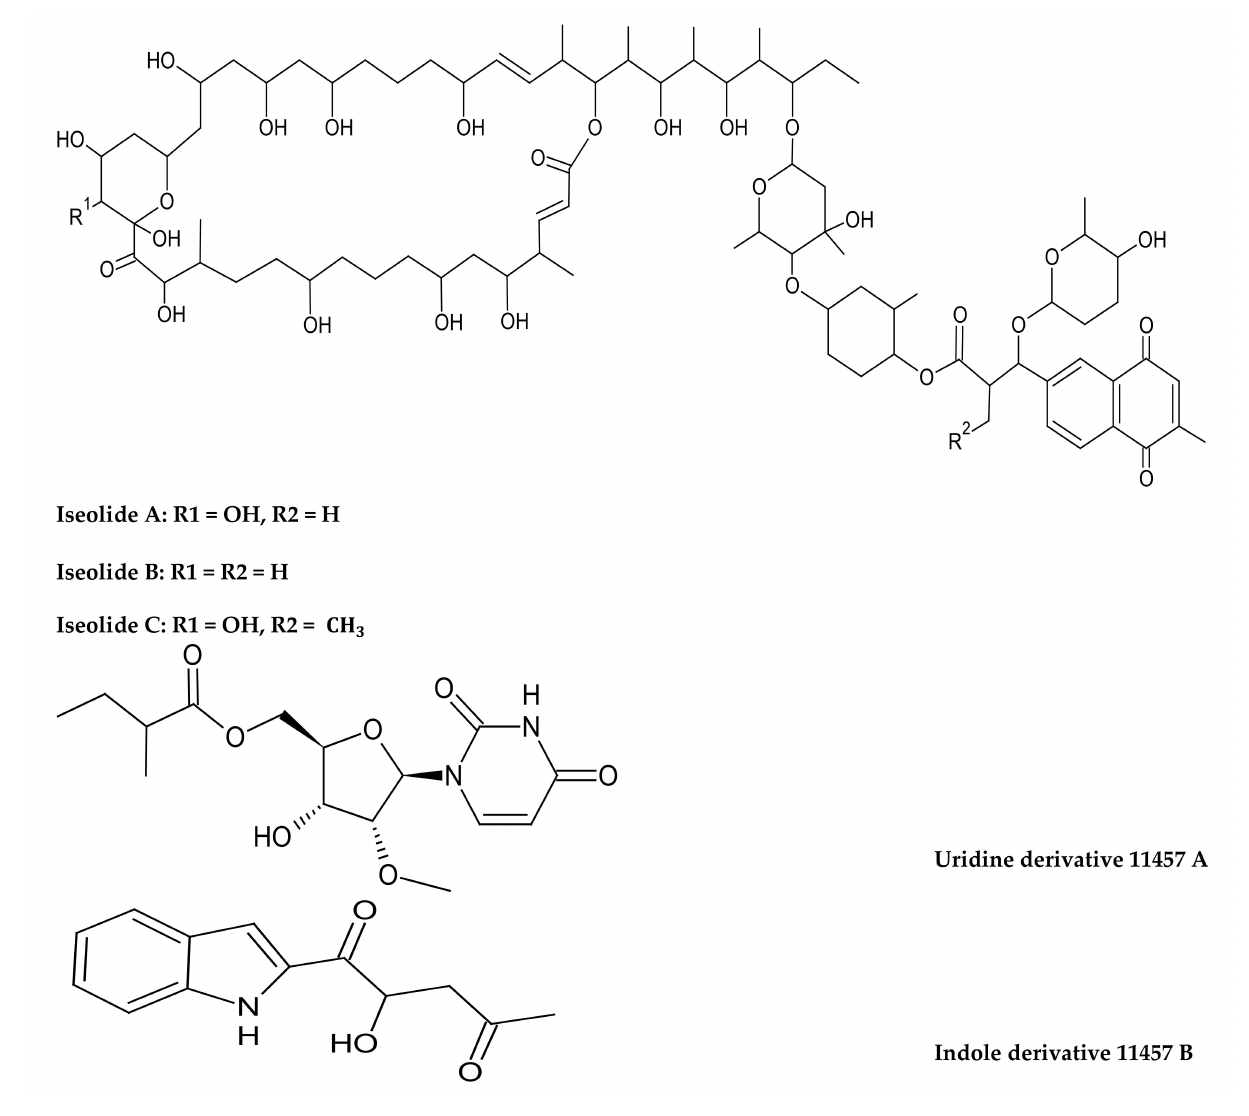
Figure 1. Structures of newly reported compounds of marine actinomycetes recovered from sclerac- tinian corals between 2007 and